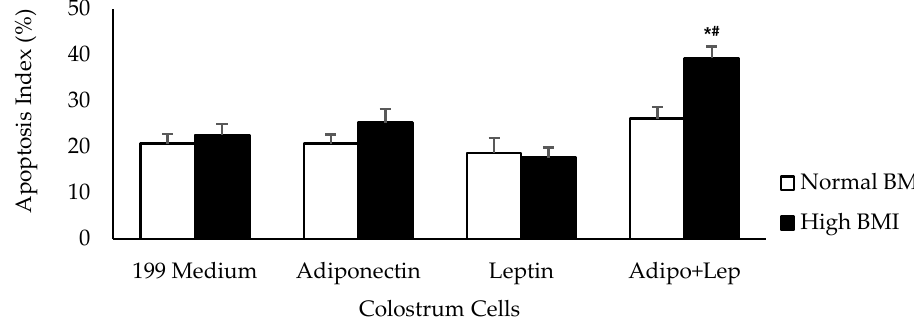
Figure 4. The effects of adiponectin and leptin on the apoptosis index of colostrum mononuclear phagocytes from women with normal BMI and high BMI values incubated with Zymosan A from Saccharomyces cerevisiae . The apoptosis assay was performed by Annexin V-fluorescein isothiocyanate (FITC) staining (n = 10). The results are presented as mean ± SD. They were assessed by ANOVA and Tukey’s test. * Statistical difference between colostrum cells incubated with 119 medium and hormones within groups ( p < 0.05). # Statistical difference among groups with the same treatment and sample ( p < 0.05).